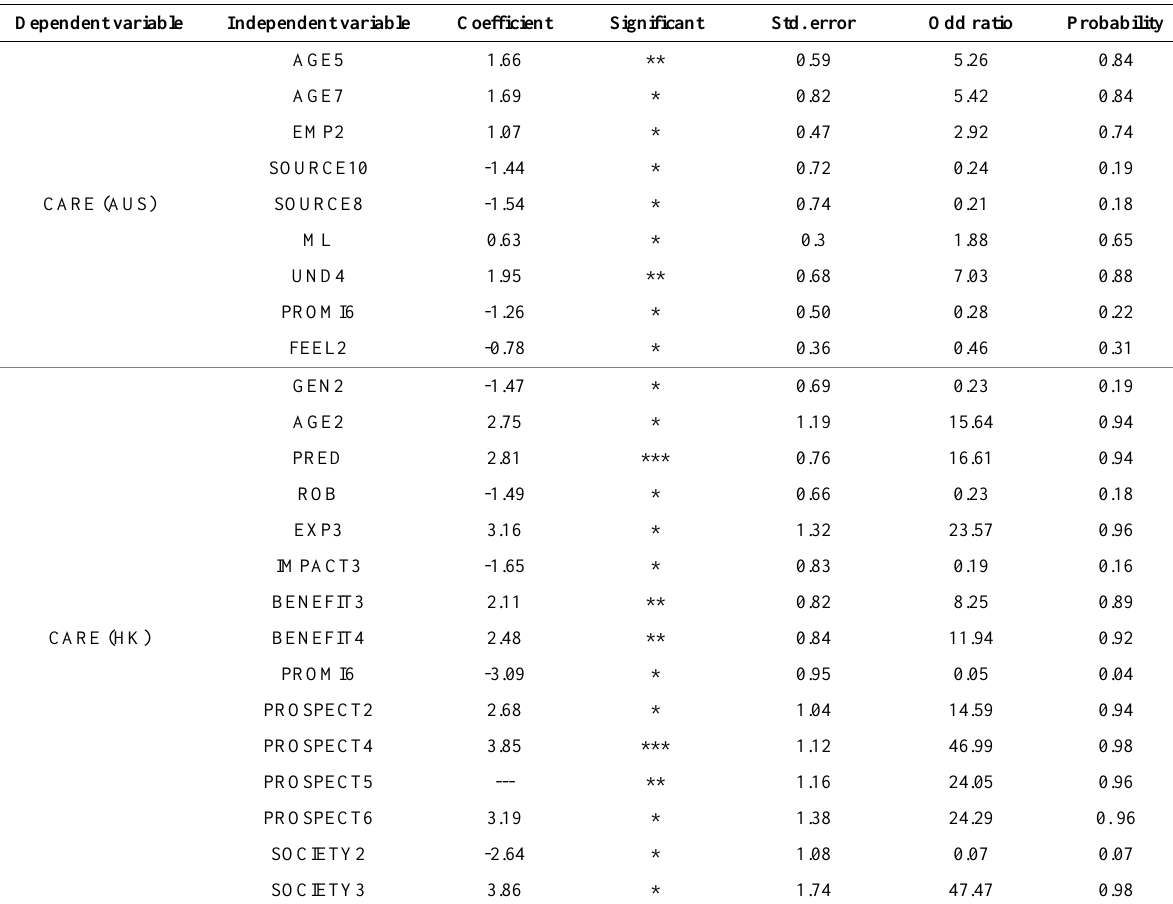
Table 4. Regression model for the application of AI to aged-care and disability in Australia and Hong Kong Dependent